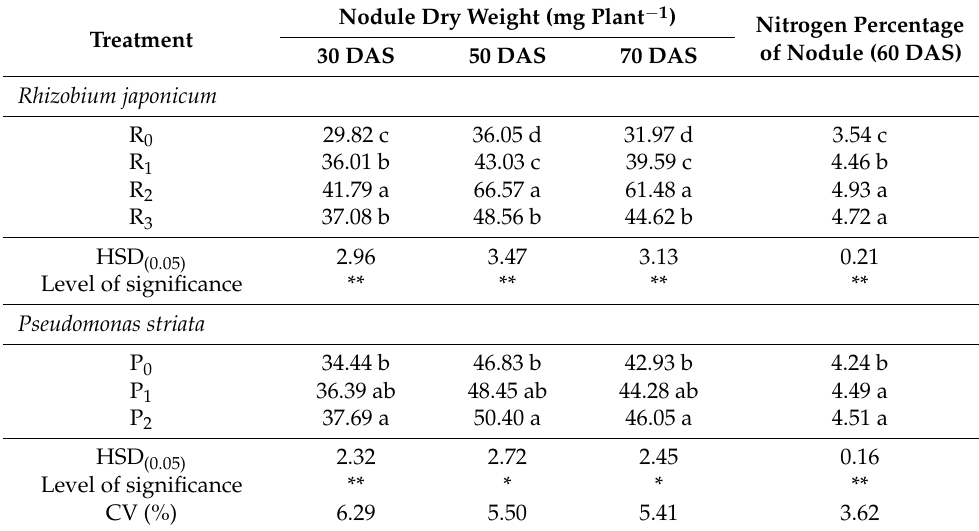
Table 5. Effect of Rhizobium japonicum and Pseudomonas striata on dry weight and nitrogen content of nodules at different days after